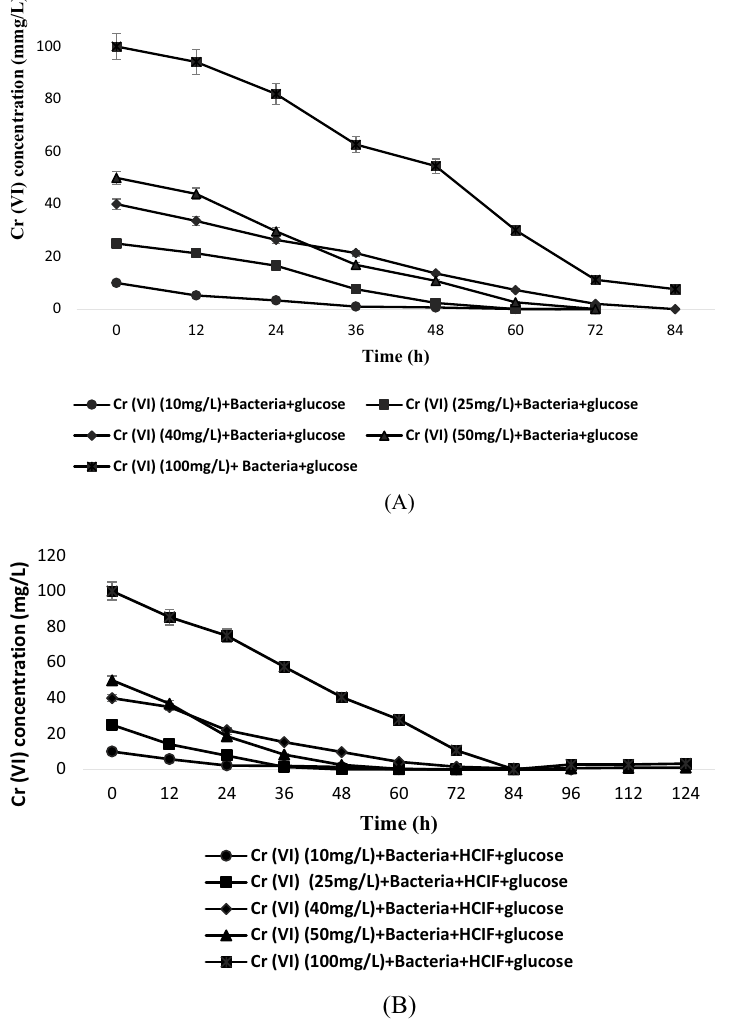
Figure 2. Changes in Cr(VI) concentration ( A ) with glucose as the only substrate ( B ) with glucose and HCIF as the cometabolic